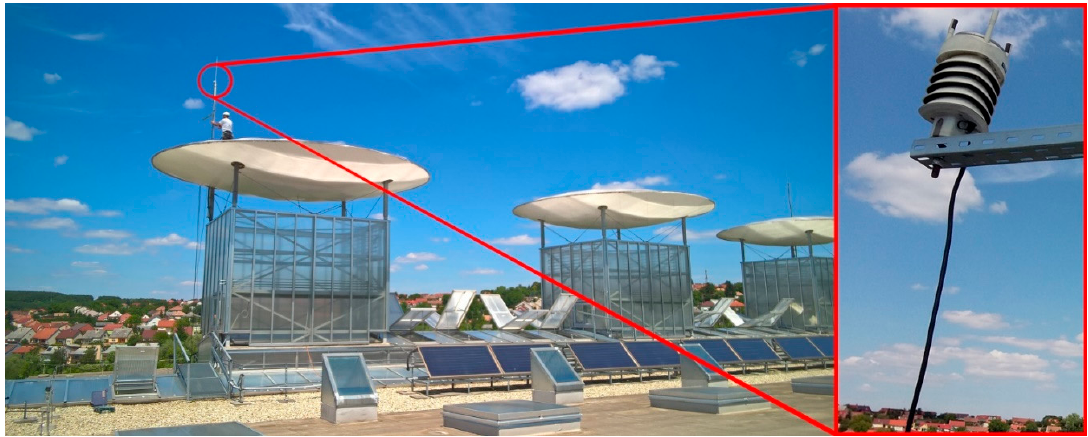
Figure 5. Installed position of Vaisala XT520 meteorological weather station on the west ventilation